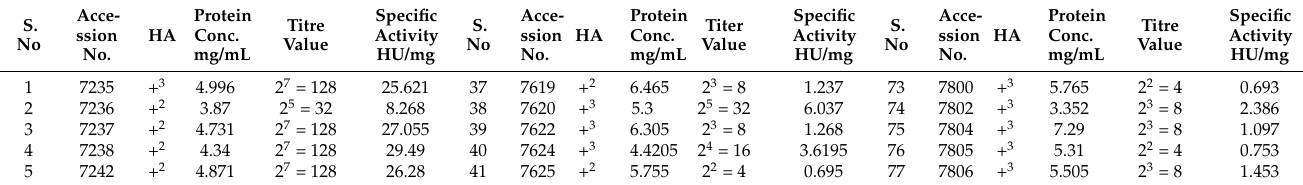
Table 4. HA, protein content (mg/mL), titer values, and specific activity in the seeds of 106 rice ( Oryza sativa L.) accessions. Acce- S. ssion No